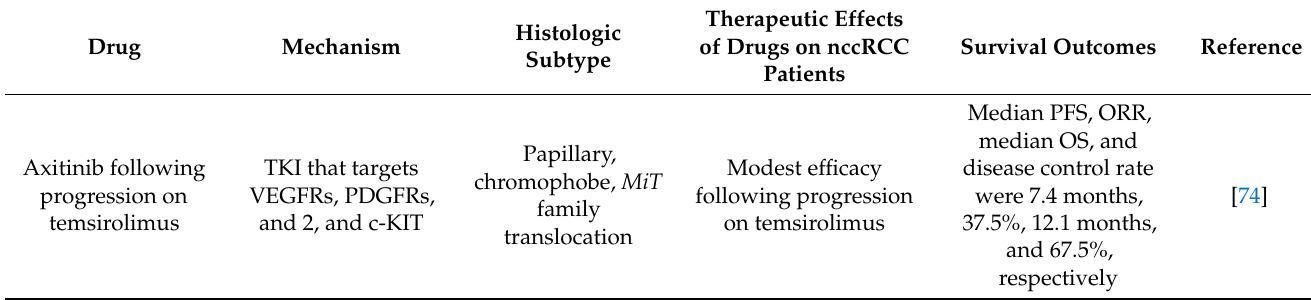
Table 2. Therapies targeting the major signaling pathways in